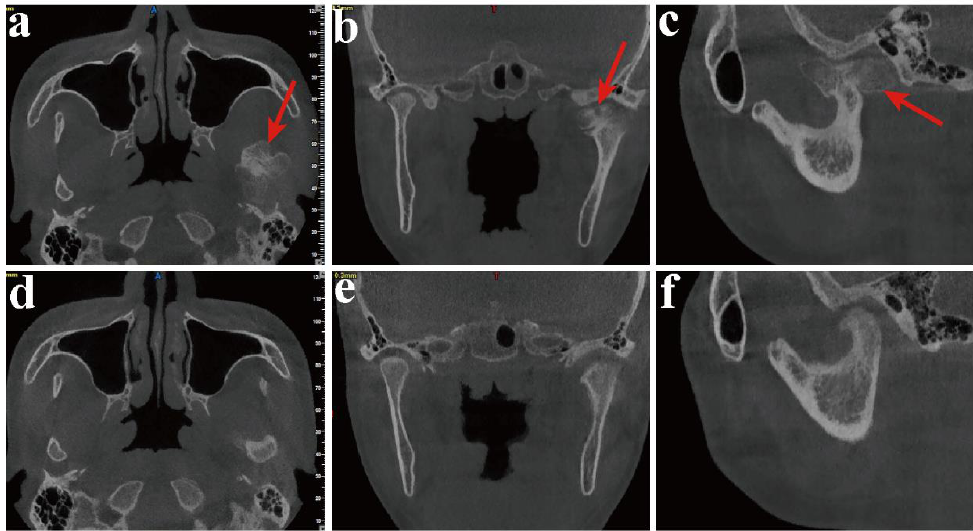
Figure 7. The change in the 2D CT image preoperatively and 1 year after surgery: ( a , d ) axial CT scan, preoperatively and postoperatively; ( b , e ) coronal CT scan, preoperatively and postoperatively; ( c , f ) sagittal view, preoperatively and postoperatively (red arrow — condylar OC) .